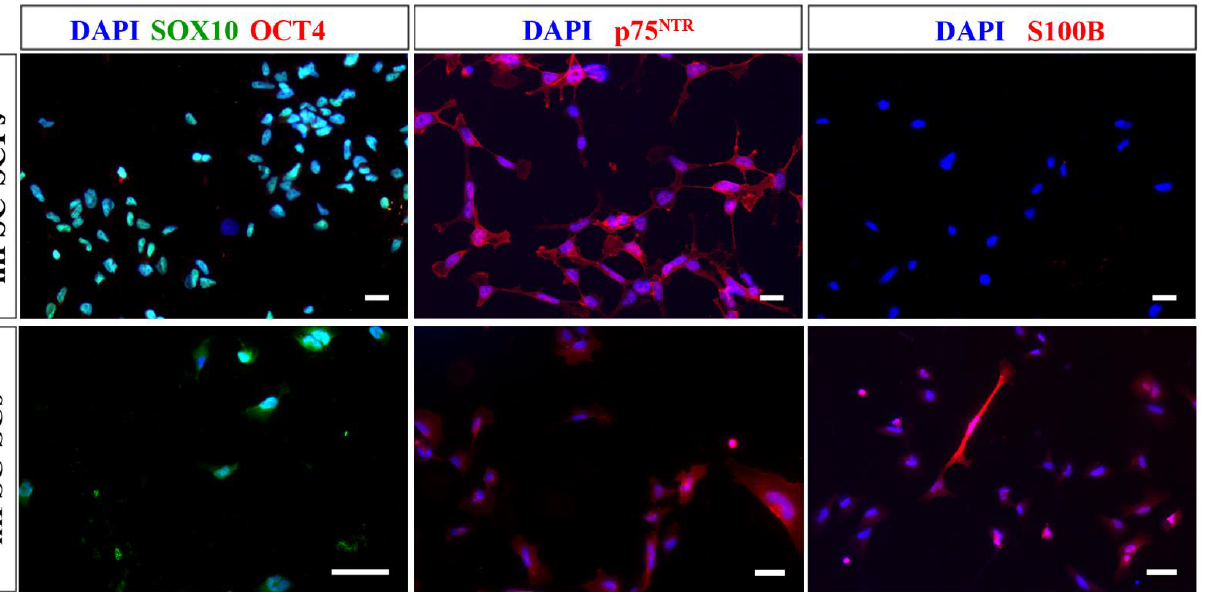
SCPs. Transcription factor AP-2 alpha ( TFAP2A) is typically associated with early neural